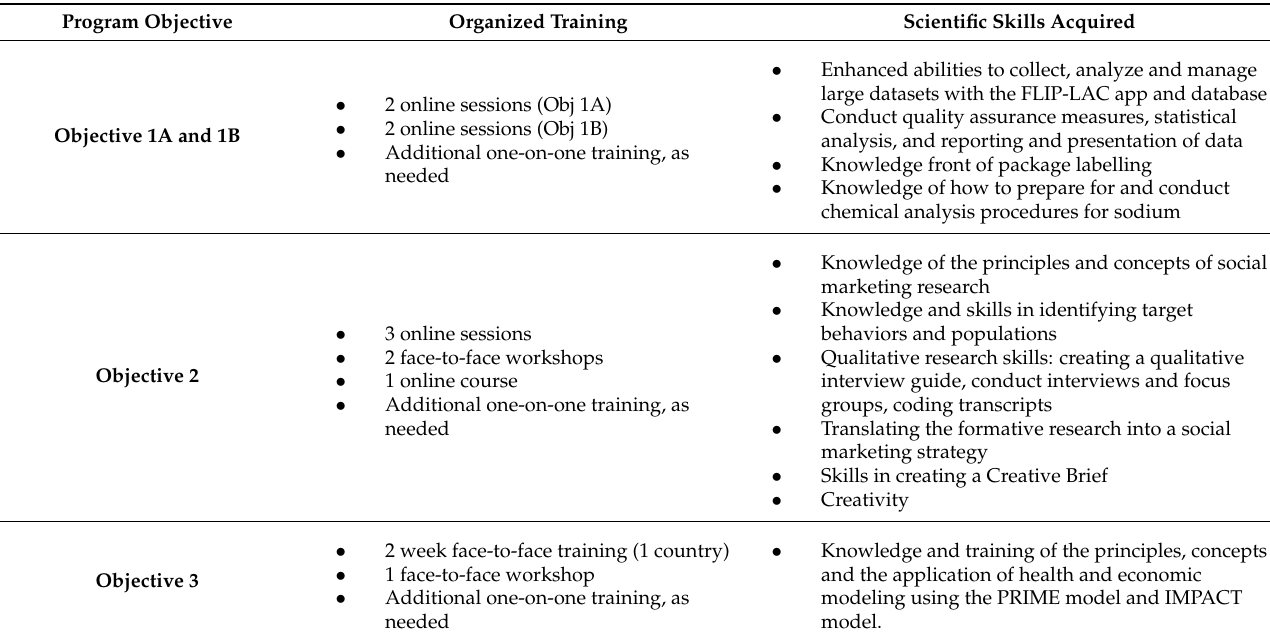
Table 1. Consortium researchers’ training and skills set development 1